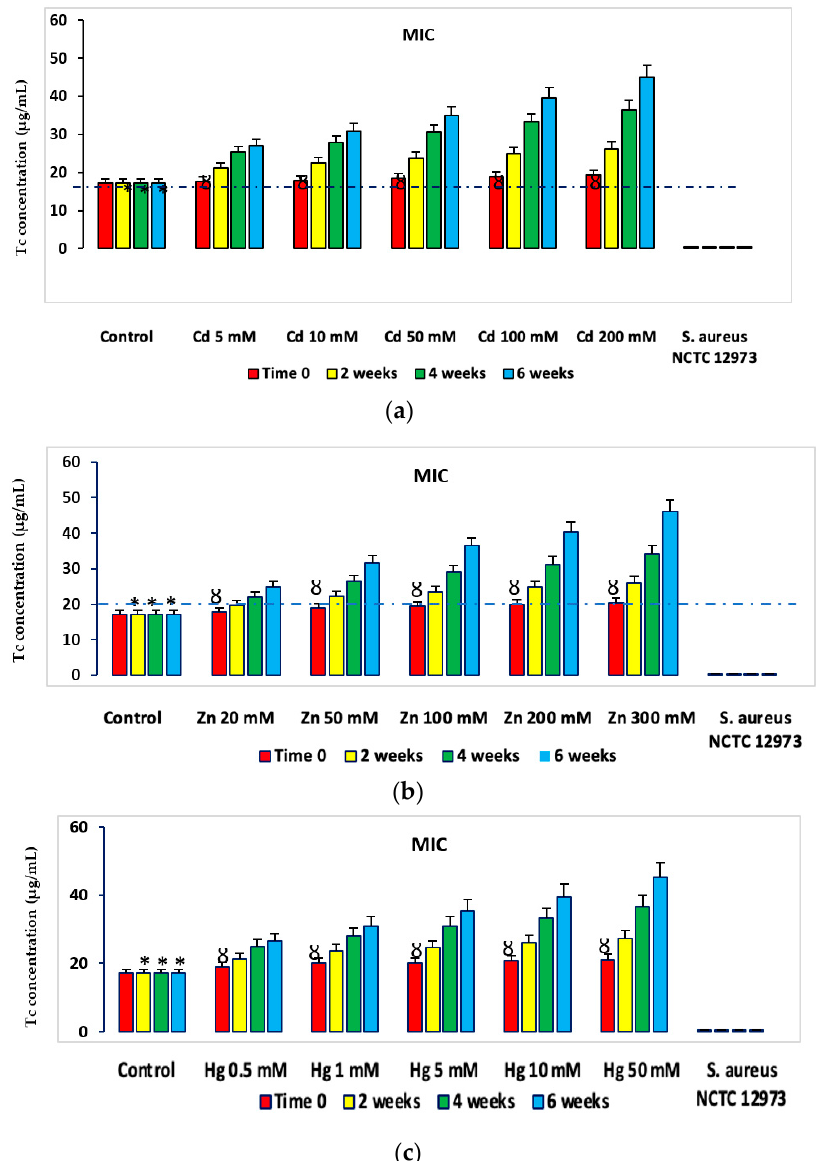
Figure 4. Mean MIC values of PICT analysis with Tc for bacteria from HM-spiked microcosms ( a ) Cd-spiked, ( b ) Zn-spiked and ( c ) Hg-spiked. * p < 0.05 compared to Tc MIC for bacteria from Cd-spiked microcosms at the same time point; Ȣ p < 0.05 compared to Tc MIC and EC50 values for bacteria from Cd-spiked microcosms at 2, 4 and 6 weeks. The dashed line defines the AbR threshold for soil bacteria. Ab-sensitive S. aureus NCTC 12973 was a negative control.